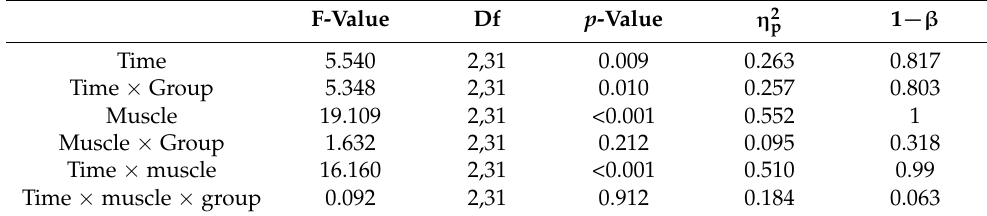
Table 3. Multivariate analysis values of right